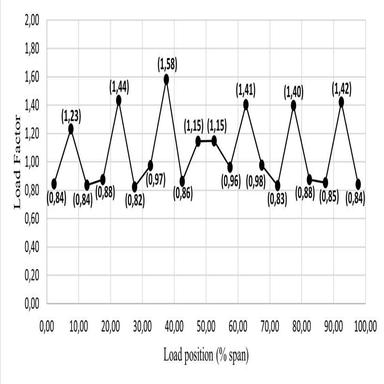
Failure load factors for the different loading positions along the span length of the bridge in the deterministic analysis.